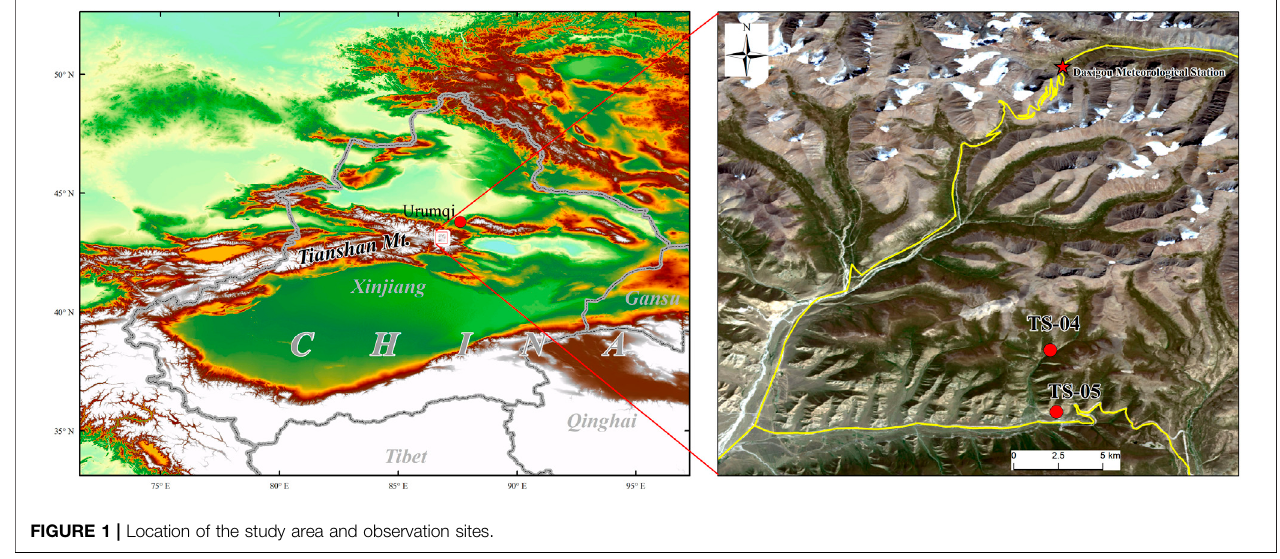
FIGURE 1 | Location of the study area and observation sites.